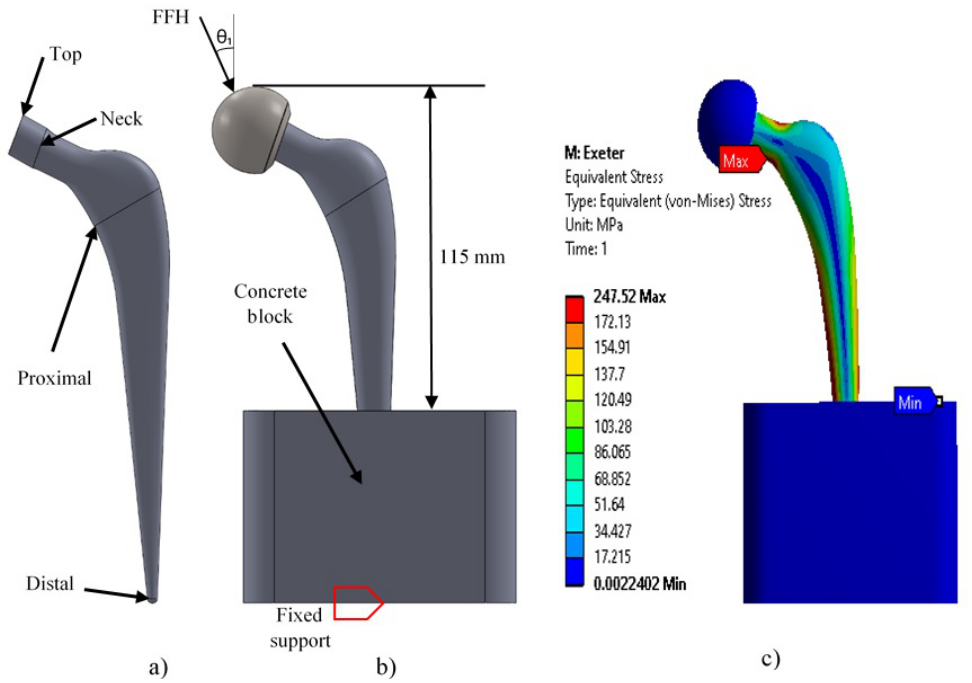
Figure 2. ( a ) Lateral view of the Exeter stem. ( b ) Assembly (block-femoral head) and boundary conditions. ( c ) Maximum stress results obtained in Exeter